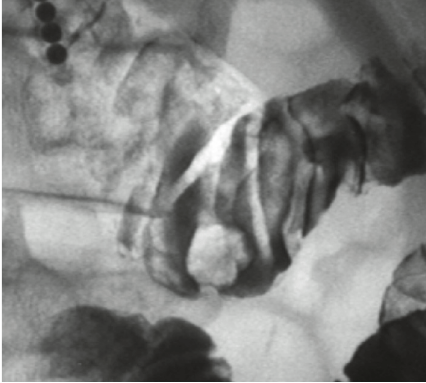
Figure 2: Hypotonic duodenography image. A submucosal tumor with bridging folds is seen in the inferior duodenal